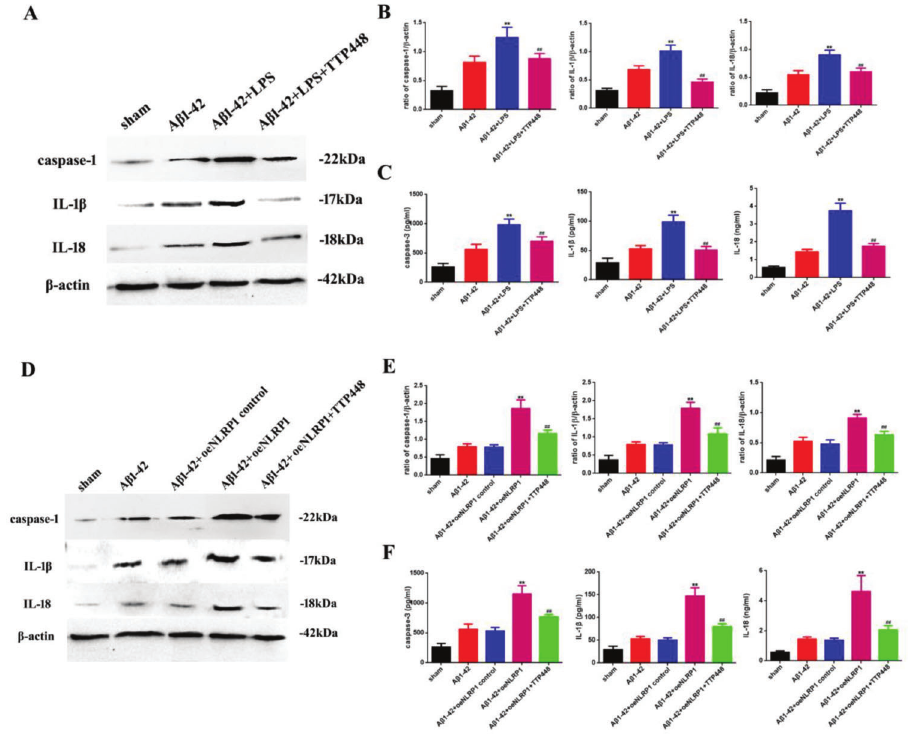
Figure 4 - (A) Western blot assay for detecting the expression of caspase-1, IL-1 b , and IL-18. (B) Quantification of the expression levels of caspase-1, IL-1 b , and IL-18. (C) ELISA assay for quantifying the expression levels of caspase-1, IL-1 b , and IL-18 in the sham, A b 1-42, A b 1- 42 + LPS, and A b 1-42 + LPS + TTP488 groups. (D) Western blot assay for detecting the expression of caspase-1, IL-1 b , and IL-18. (E) Quantification of the expression levels of caspase-1, IL-1 b , and IL-18. (F) ELISA assay for quantifying the expression levels of caspase-1, IL-1 b , and IL-18 in the sham, A b 1-42, A b 1-42 + control oeNLRP1, A b 1-42 + oeNLRP1, and A b 1-42 + oeNLRP1 + TTP488 groups. Protein levels were normalized to those of b -actin (A b 1-42 + LPS or A b 1-42 + oeNLRP1 vs . A b 1-42 group, ** p o 0.05; A b 1-42 + LPS + TTP488